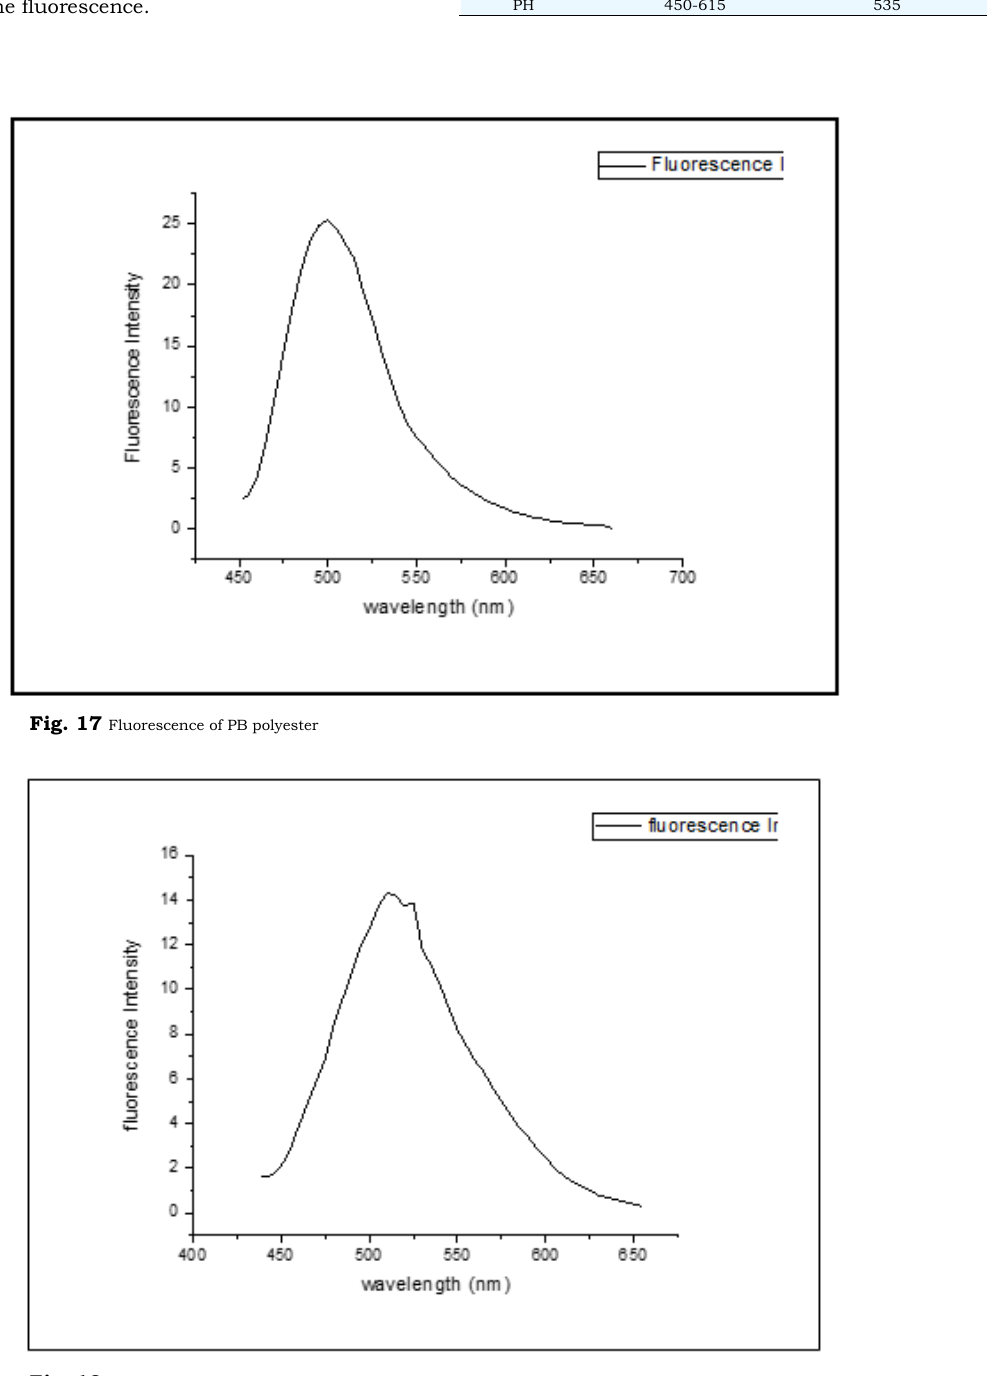
Fig. 18. Fluorescence of PD